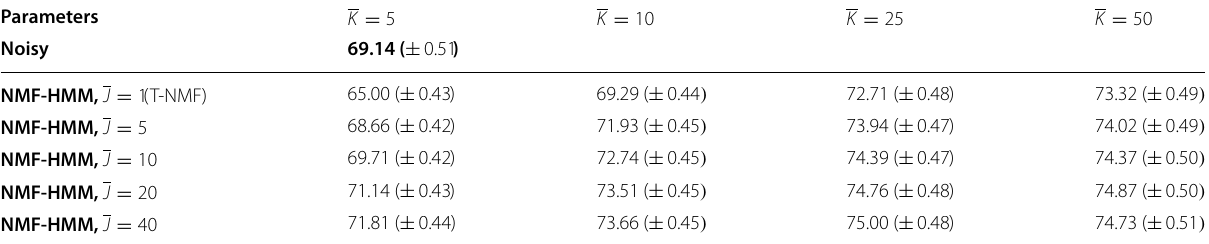
Table 1 Average STOI scores (%) comparisons of different clean speech states and basis vectors ( ¨ J = 1, ¨ K = 70 )